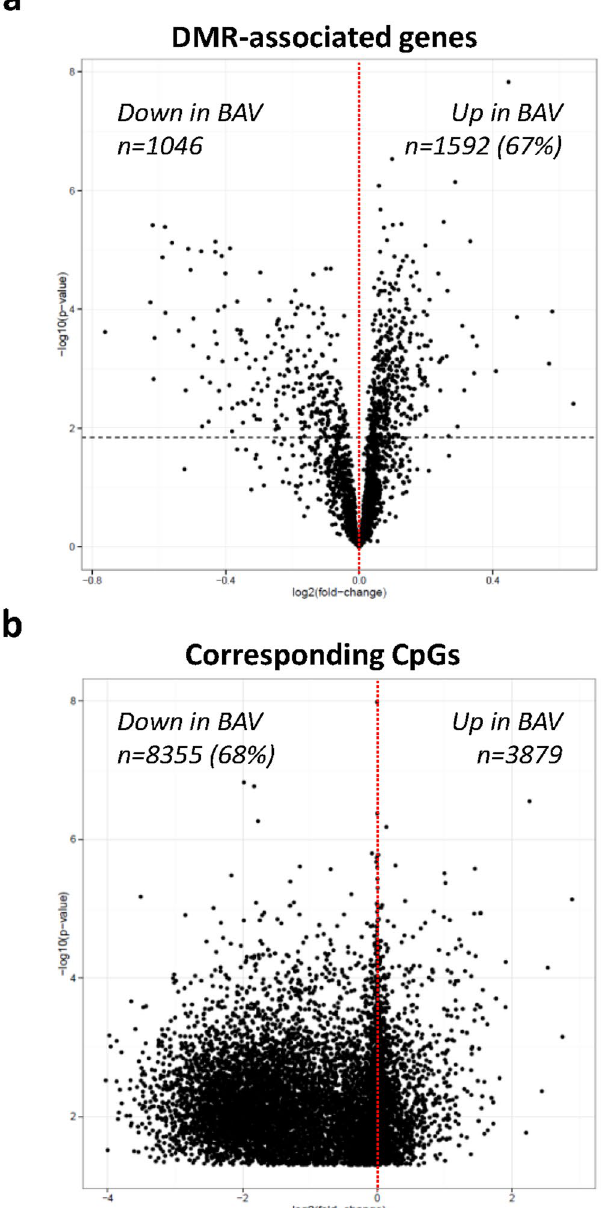
Figure 2. Relationship between gene expression and DNA methylation, BAV and TAV dilated aortas. Volcano plots of − log10 (P-value) against log2 (fold-change) of ( a ) gene expression and ( b ) DNA methylation beta values, of DMR-associated genes and their corresponding CpGs. Dashed horizontal line represents the Bonferroni-adjusted threshold for statistical significance (t-test). N = 14 BAV and N = 13